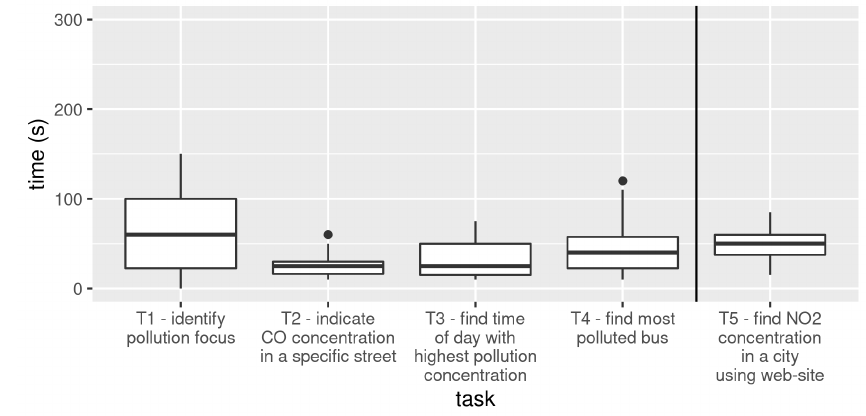
Figure 12. Box plot of completion times taken by the participants that were successful in each